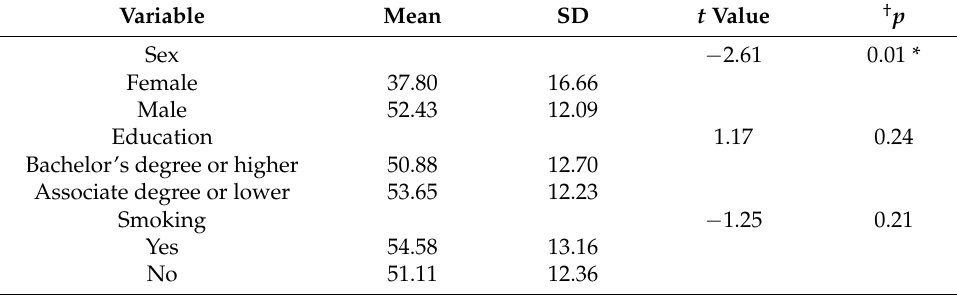
Table 2. Correlations among demographic characteristics, disease characteristics, psychological symptoms, and quality of life in patients with mood or adjustment disorder ( n =